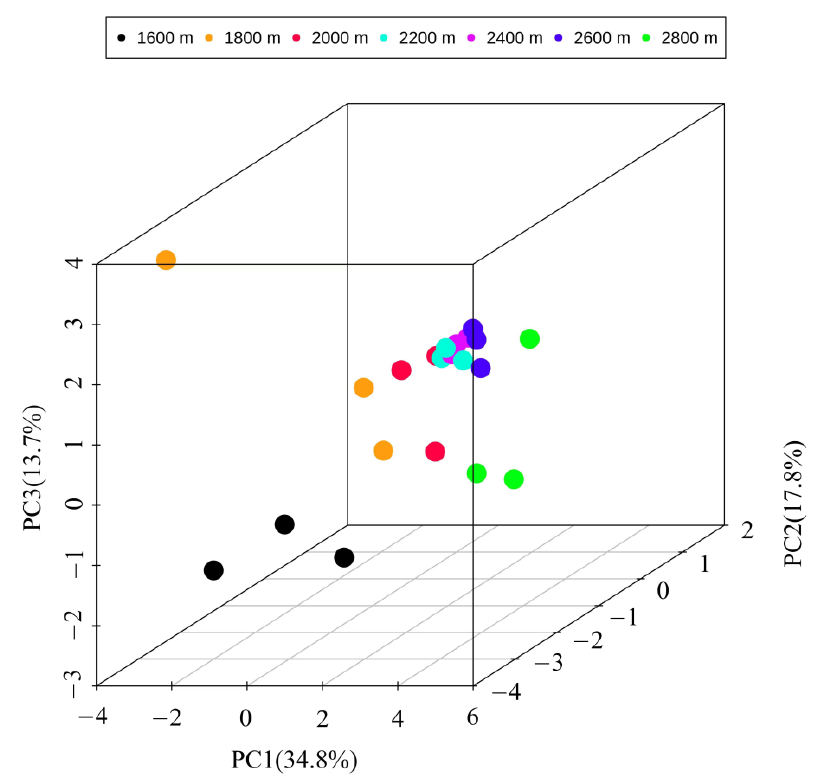
Figure 3. Principal components analysis of insect community along altitudinal gradient in the Guandi Mountain.